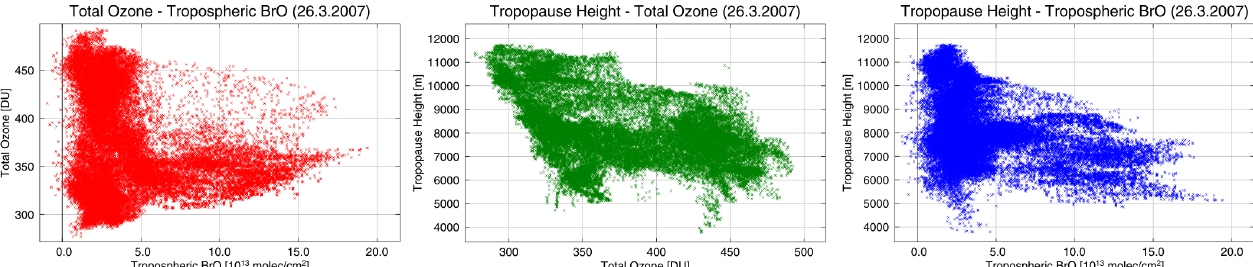
Fig. 8. Scatter plots of total ozone, tropopause height and tropospheric BrO from GOME-2